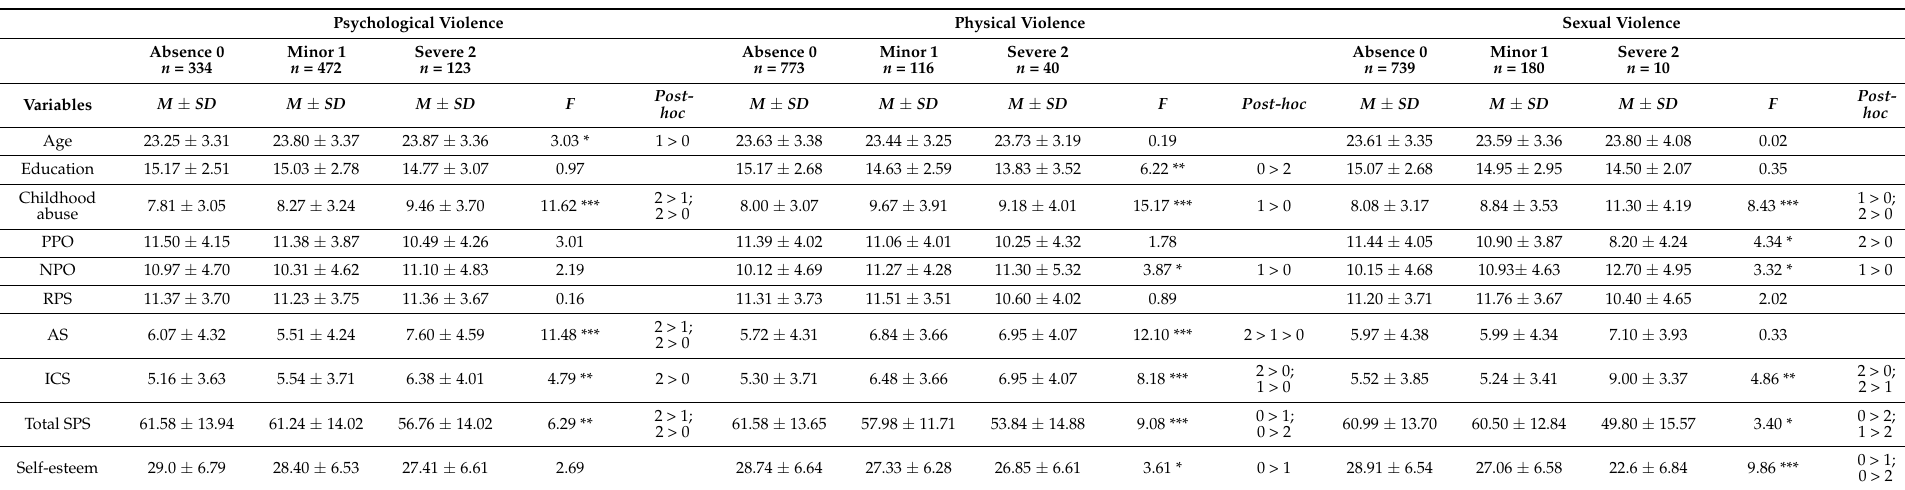
Table 2. Differences Between Severity of IPV, SPS and